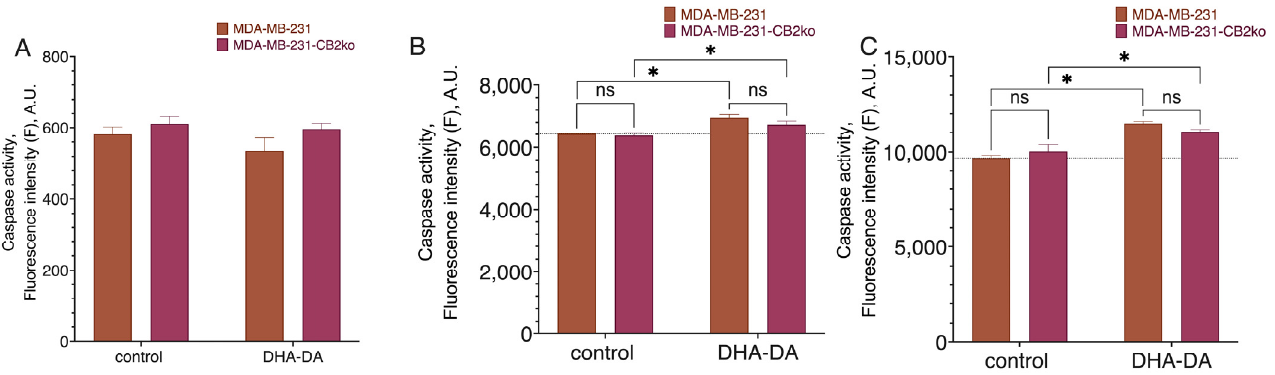
Figure 9. Effect of DHA ‐ DA (40 μ M) on the caspase activation in the MDA ‐ MB ‐ 231 cell line after CB2 receptor knockout. A total of 3 h incubation time fluorogenic substrate measurement data: ( A ) caspase 8, ( B ) caspase 9, ( C ) caspase 3; *, a statistically significant difference from the control without